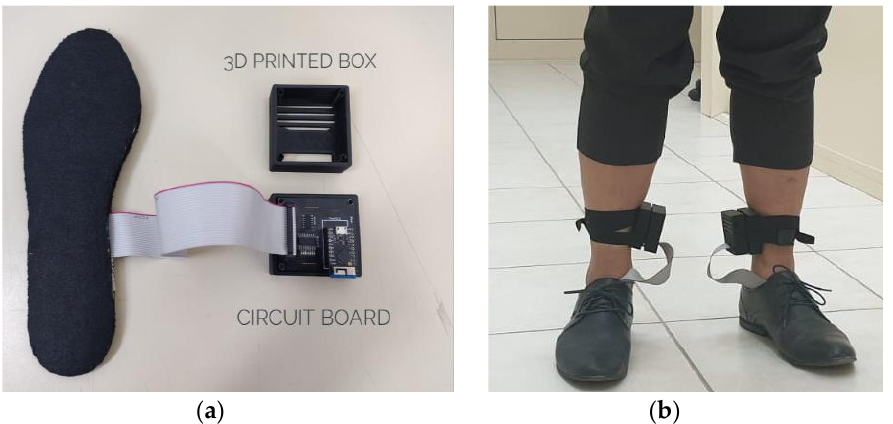
Figure 8. ( a ) Complete setup comprising of the insole, 3D printed box and the printed circuit board, ( b ) Setup placed on the human leg.